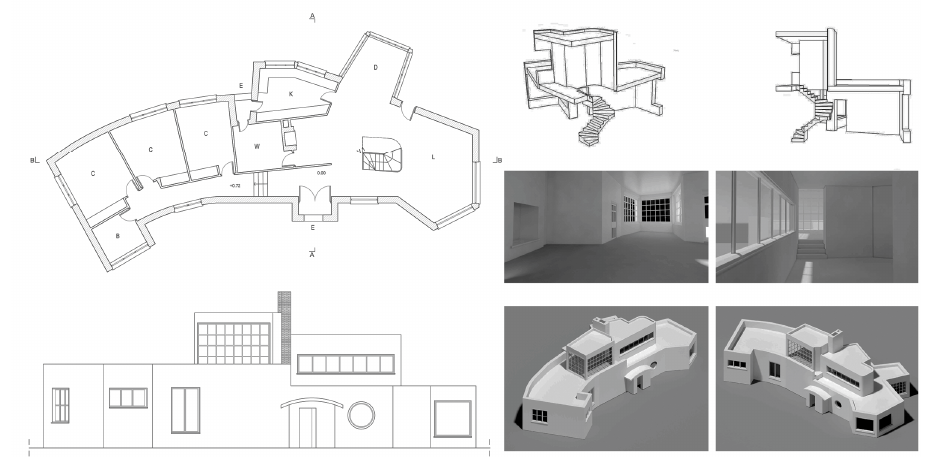
Figure 4. House 2. Plan, front, schemes, isometric views, perspectives (C.